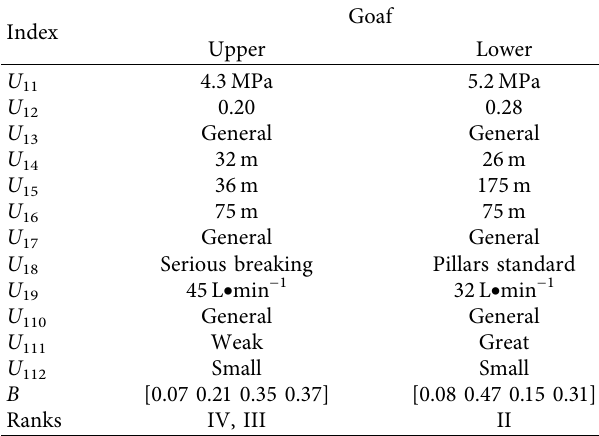
Figure 2: Te situation of goafs. (a) Te location of the open pit and goafs. (b) Te section of exploration line X . Table 2: Stability evaluation of upper goaf and lower